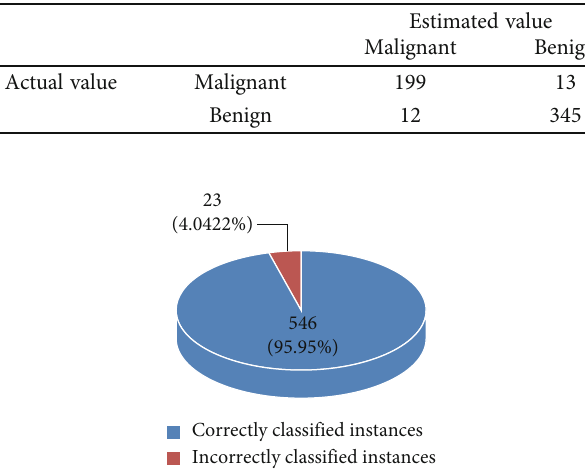
Figure 10: Accuracy and sensitivity information of the J48 technique. Table 6: Complexity matrix of the KNN technique.